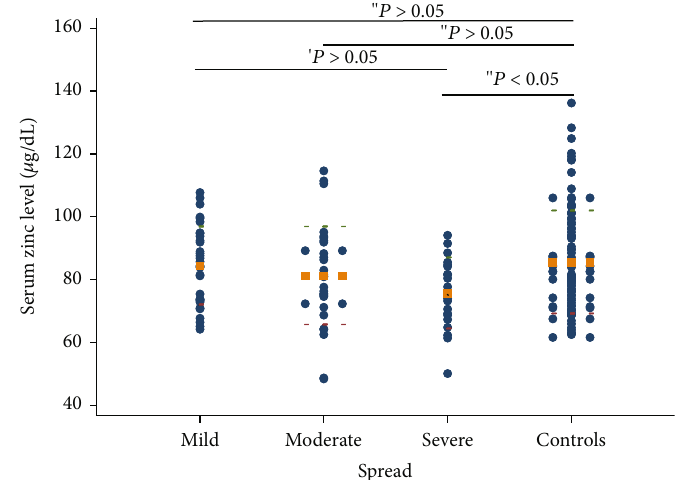
Figure 2: The relationship between the mean serum level of zinc and the spread of genital warts (ANOVA test; Student ’ s t -test). The round dots show values of serum zinc level, and the orange square dot lines show mean values.